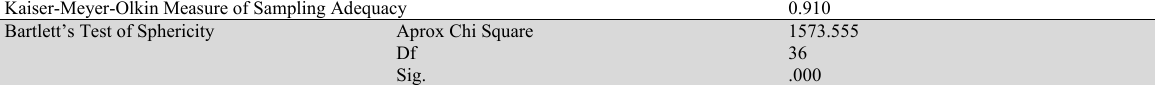
Workplace Spirituality Validity Result (used CFA analysis: KMO and Bartlett’s Test) Kaiser-Meyer-Olkin Measure of Sampling